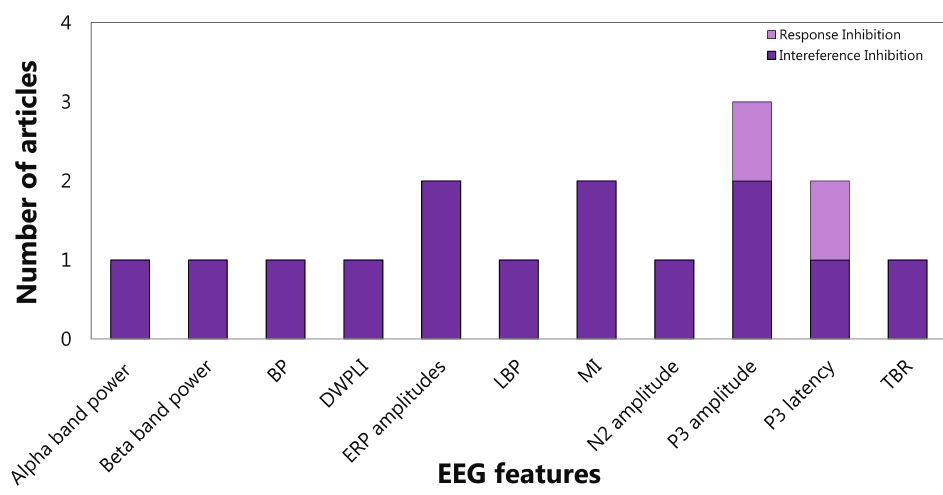
Figure 14. EEG features for inhibition’s sub-function emerged from highest quality articles.